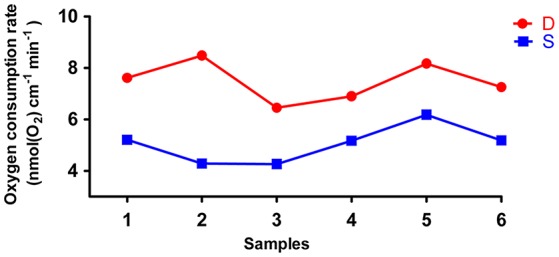
The oxygen consumption rates of six pairs of deep roots and shallow roots. D is deep roots and S is shallow roots. The 1–6 at X-axis is the six replicates of the samples.